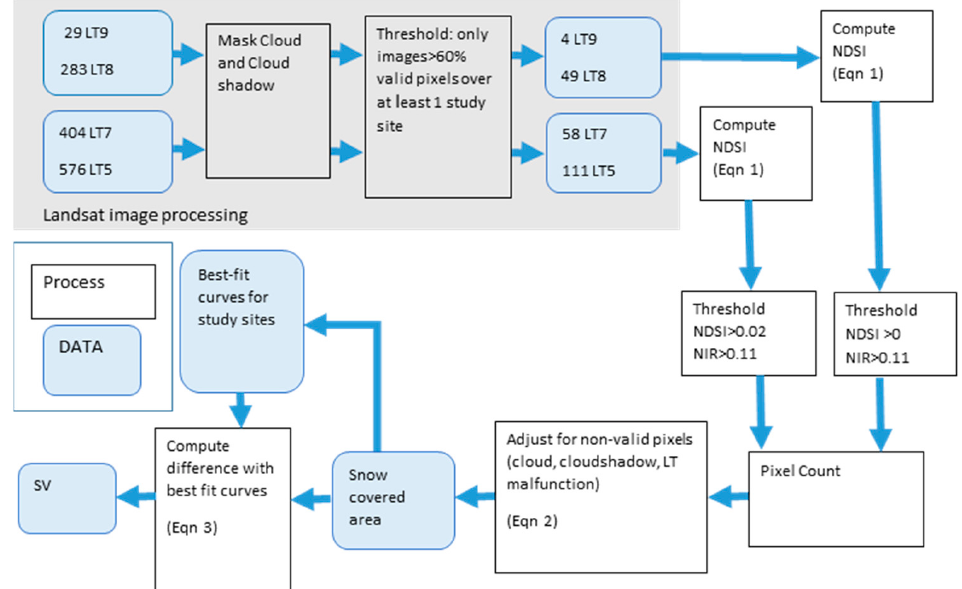
Figure 3. Overall workflow to determine snow cover value (SV) from Landsat imagery. LT is the abbreviation for Landsat; Eqn for Equation.